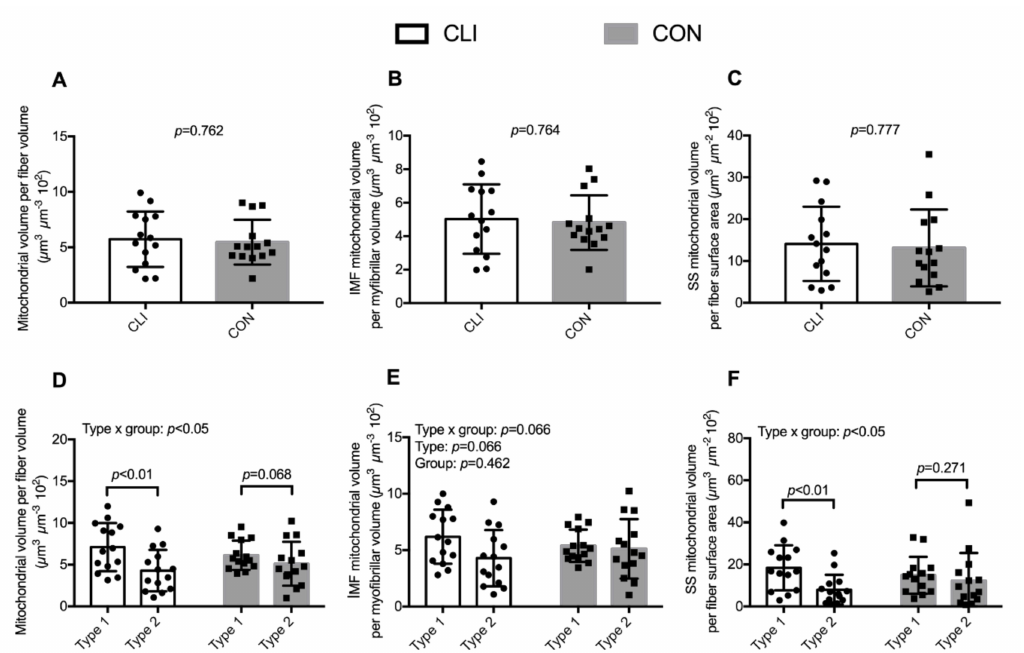
Figure 4. Mitochondrial content for CLI (n = 14) and CON (n = 14) patients. ( A – C ) Total, IMF, and SS mitochondrial volume fraction, respectively. ( D – F ) Total, IMF, and SS mitochondrial volume fraction stratified for fiber type, respectively. Data are presented as means ± SD. Overall linear mixed model e ff ects are designated in the upper left corner of graphs